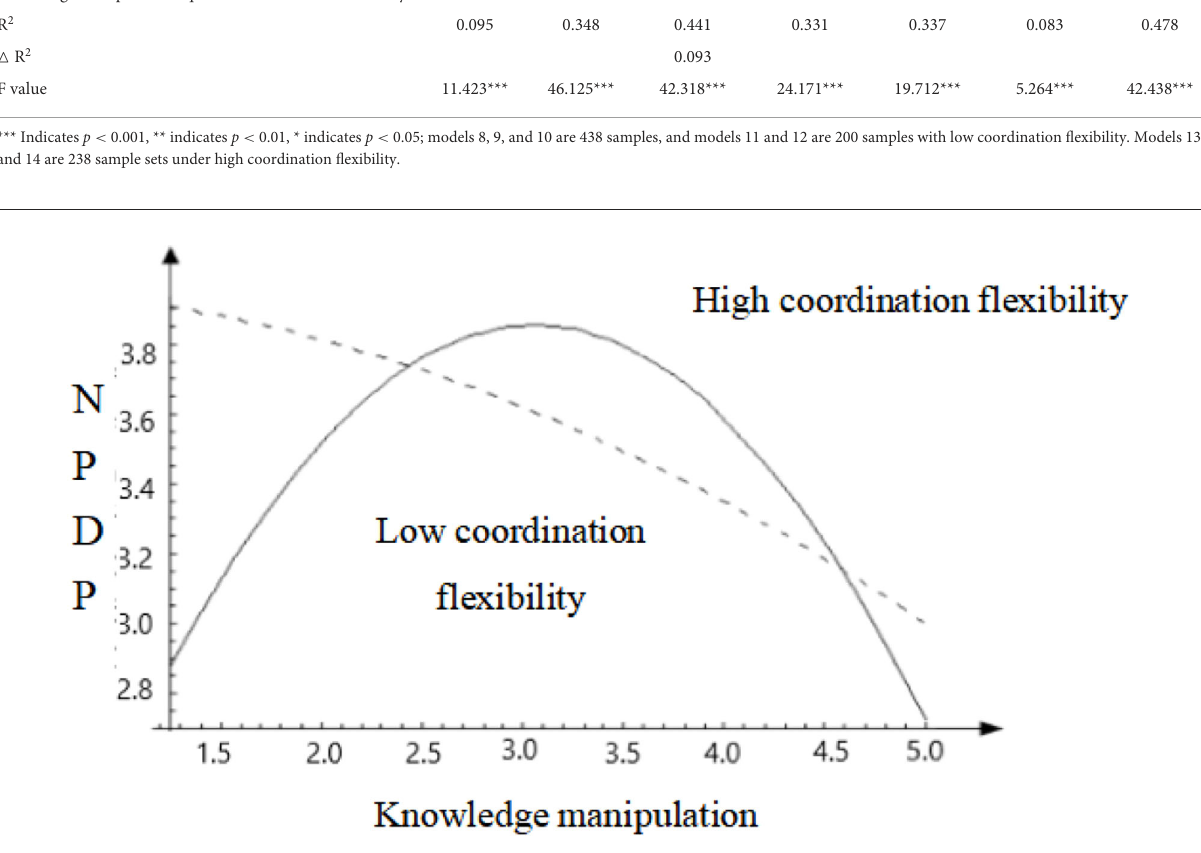
FIGURE2 Moderating effect of coordination